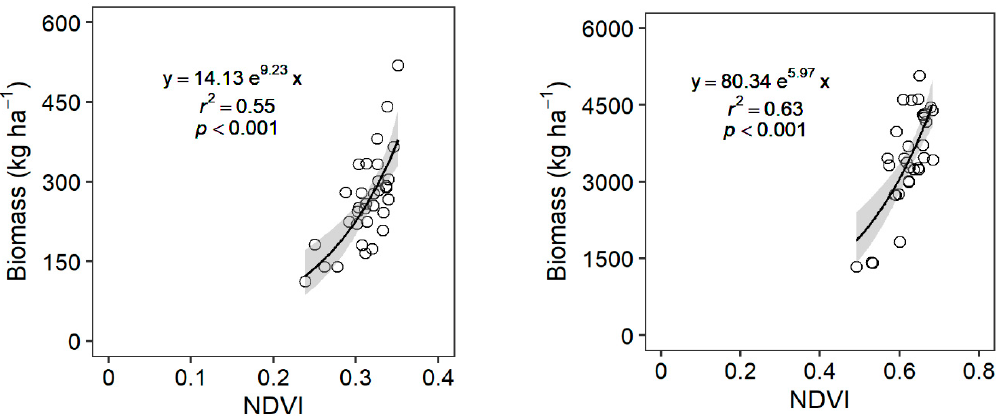
Figure 4. Relationship between normalized difference vegetation index (NDVI) and maize biomass at five (left) and ten (right) leaf collar growth stages.